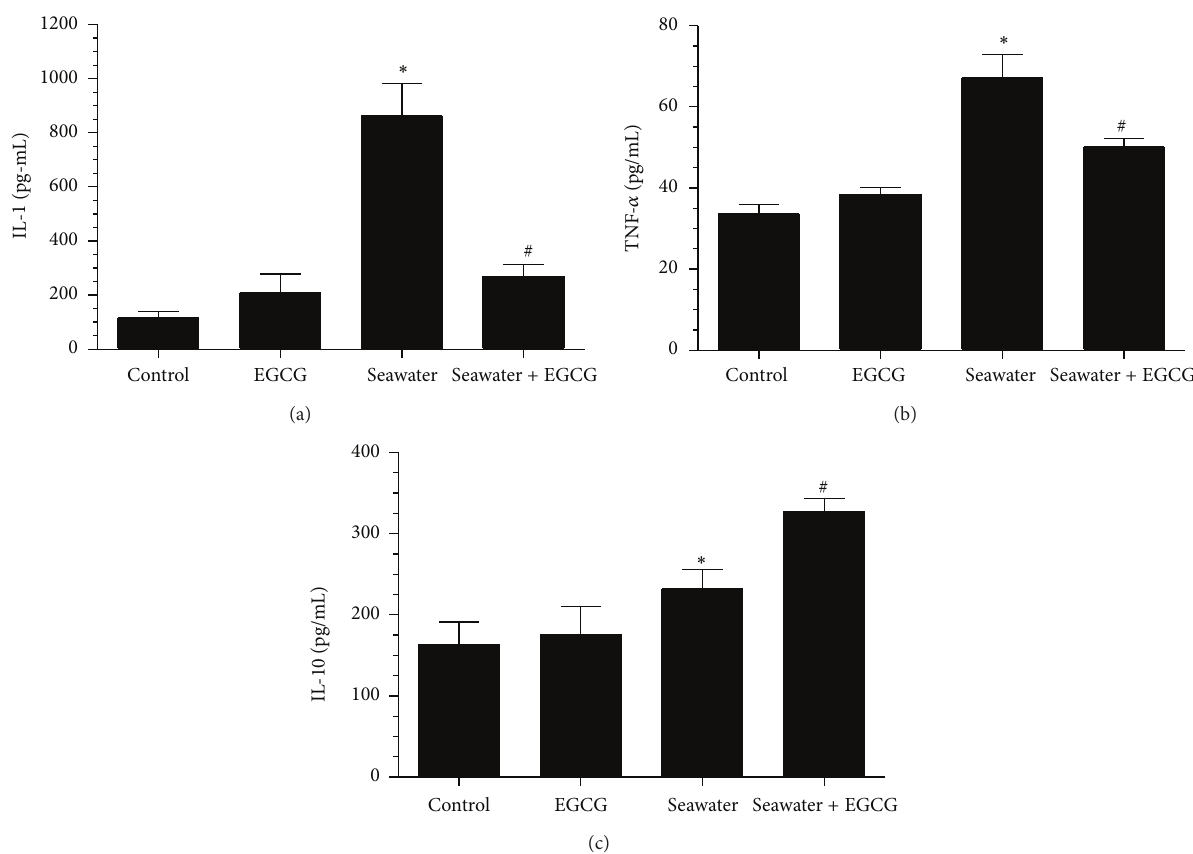
Figure 8: Effects of EGCG pretreatment on IL-1, TNF- 𝛼 , and IL-10 of lung tissue in seawater aspiration-induced ALI. IL-1 (a), TNF- 𝛼 (b), and IL-10 (c) increased in seawater group. EGCG pretreatment downregulated the levels of IL-1 and TNF- 𝛼 and upregulated the level of IL-10. Data were presented as mean ± SEM ( 𝑛 = 12 ). ∗ 𝑃 < 0.05 versus control group; # 𝑃 < 0.05 versus seawater group.